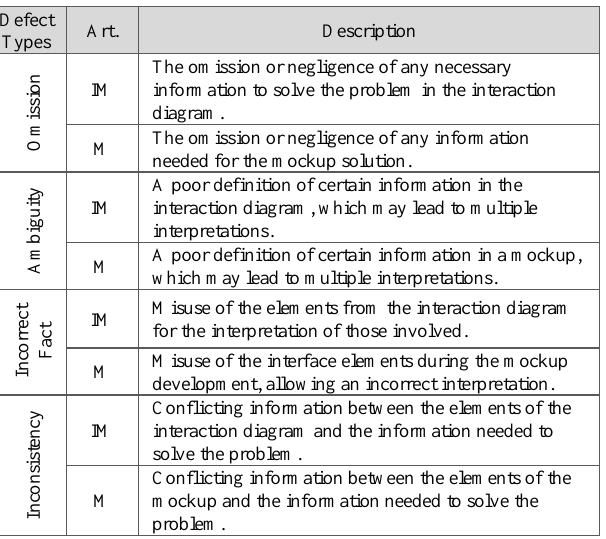
TABLE IV. D EFECT TAXONOMY FOR INTERACTION M ODELS (IM) AND MOCKUPS (M) DEFINED BY L OPES ET AL . [1]. Defect Art. Types